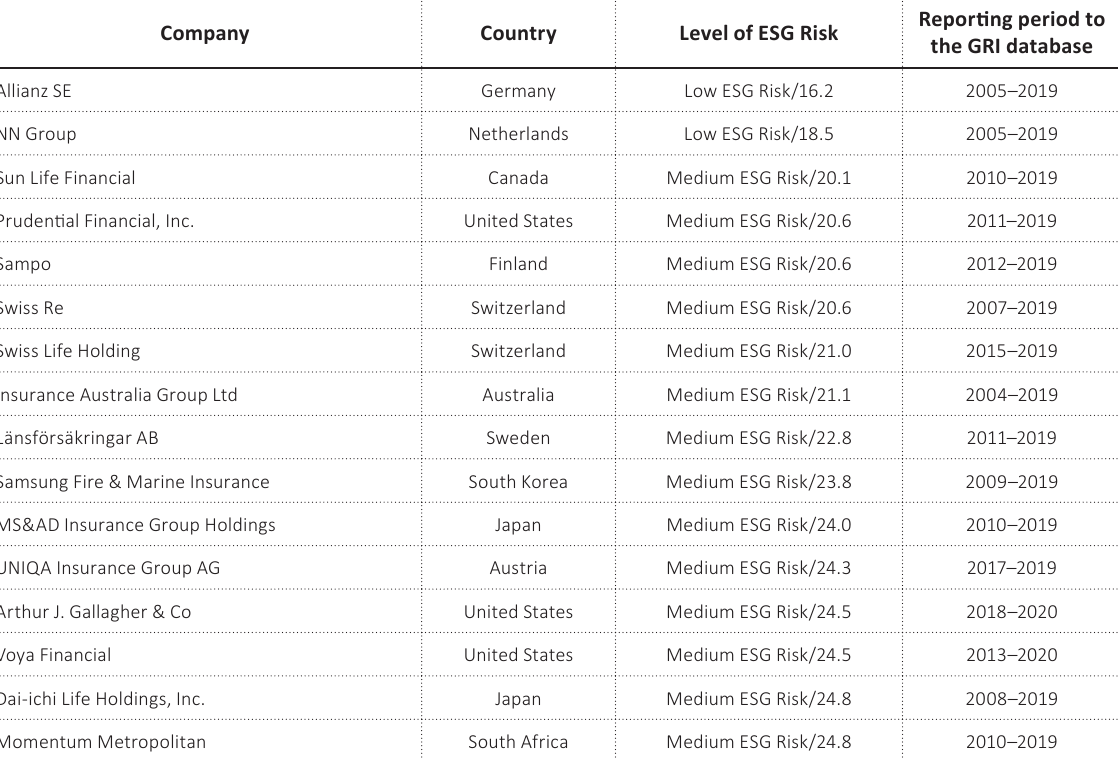
Table 3. A sample of insurance companies for in-depth study of the effectiveness of the ESG-driven